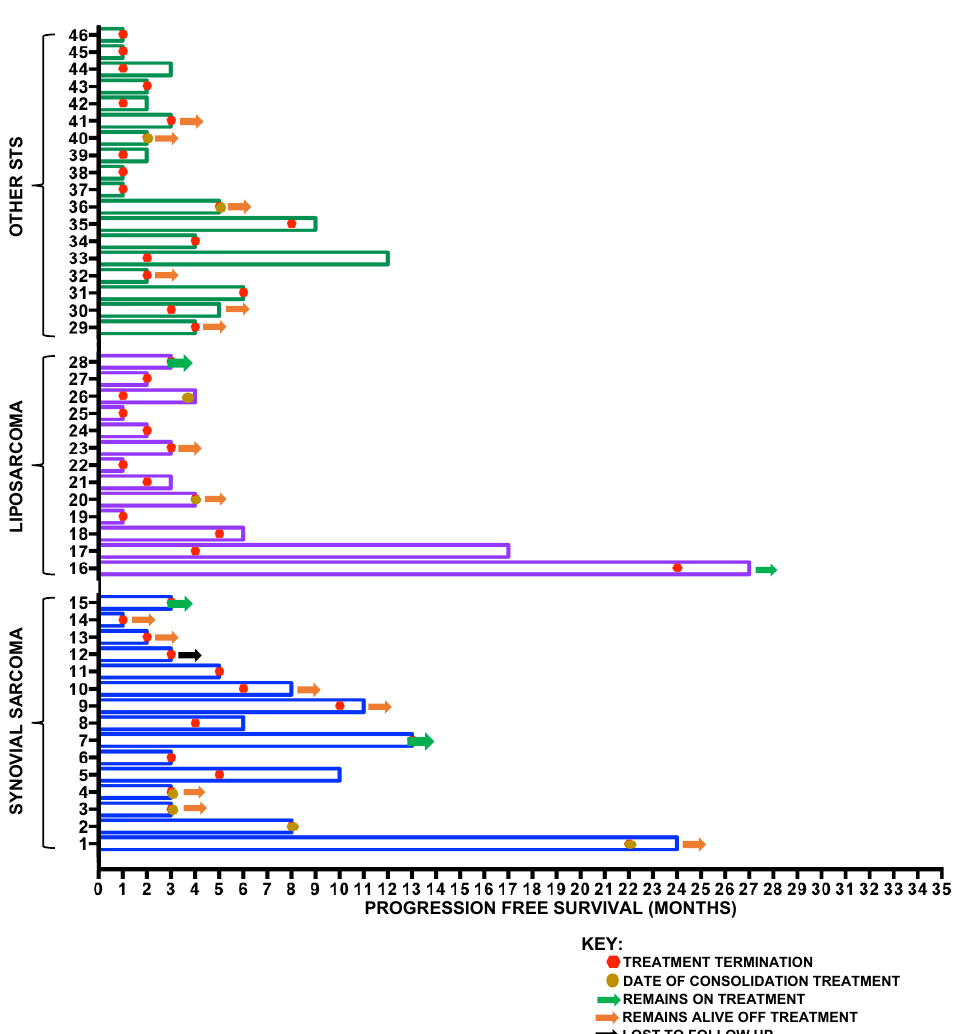
Figure 3. Swimmer plot of STS cohort demonstrating PFS, timing of treatment cessation, and patient status at the time of analysis. Patients 1–15 represent those with synovial sarcoma, patients 16–28 represent those with liposarcoma, whilst patients 19–46 represent those with other STS subtypes.